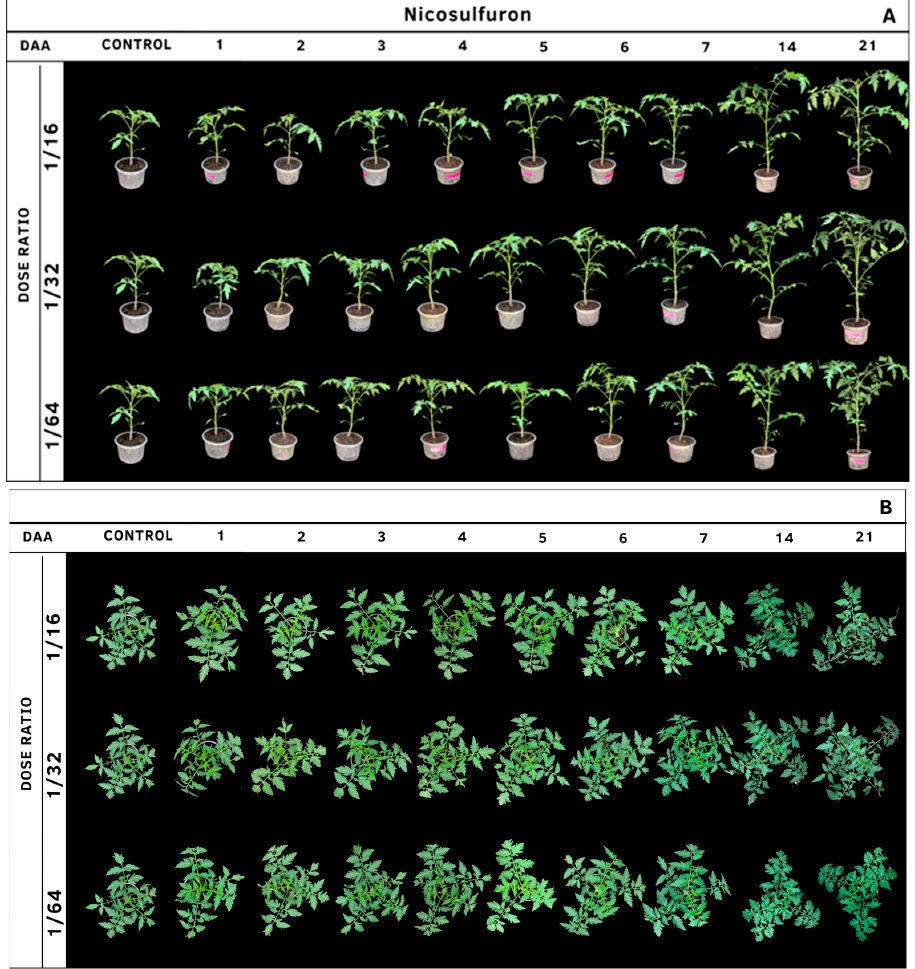
Figure 17. Symptoms evolution in tomato plants due to simulated nicosulfuron drift at dose ratios 1/16D, 1/32D, and 1/64D (3.75, 1.88, and 0.94 g a.i. ha − 1 , respectively) of the recommended dose (D). Evaluations were made from 1 to 7, 14, and 21 days after application (DAA). Front view ( A ) and top view ( B ) of tomato plants a ff ected by simulated drift. The symptoms caused by simulated isoxa fl utole drift in tomatoes are characterized by albino young leaves followed by necrosis (Figures 18 and 19). The onset of symptoms was observed 1 DAA of the simulated herbicide drift in all applied dose ratios.